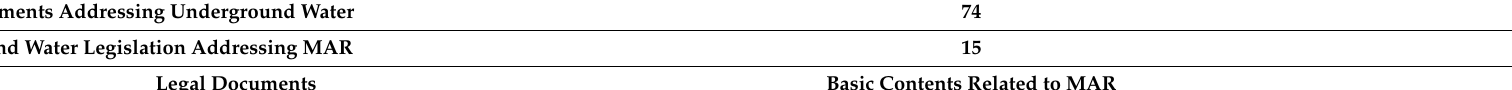
Table 3. Legal Framework at the State